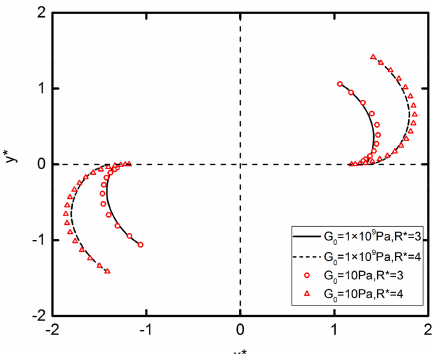
Figure 10. Trajectories of two particles initially located with θ = 45 ◦ and R * = 3 subjected to an external electric field E ∗ = 0.05. Lines and symbols represent G 0 = 1 × 10 9 Pa and G 0 = 10 Pa, respectively. Solid lines and circles represent R * = 3. Dashed lines and triangles represent R * = 4.